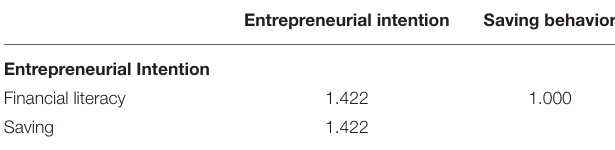
TABLE 5 | Collinearity results.